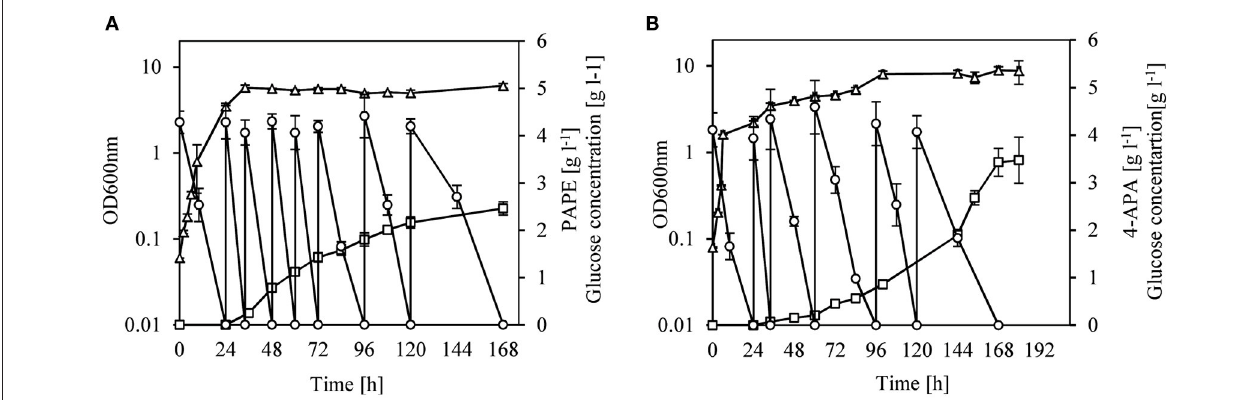
FIGURE 4 | Fed-batch cultivation of E. coli FUS4BCR/pC53BCAY/pJNT aroFBL-yahK (A) or E. coli FUS4BCR/pC53BCAF/pJNT aroFBL-feaB (B) for PAPE or 4-APA production. Cell growth (empty triangles) was determined by measuring OD 600 , glucose concentration (empty circles) and the total PAPE or 4-APA production (empty squares) in the minimal media were determined by using HPLC. The cells were cultivated in 20ml minimal media for 168h. The data represent the mean and standard deviations from measurements of three biological replicates.